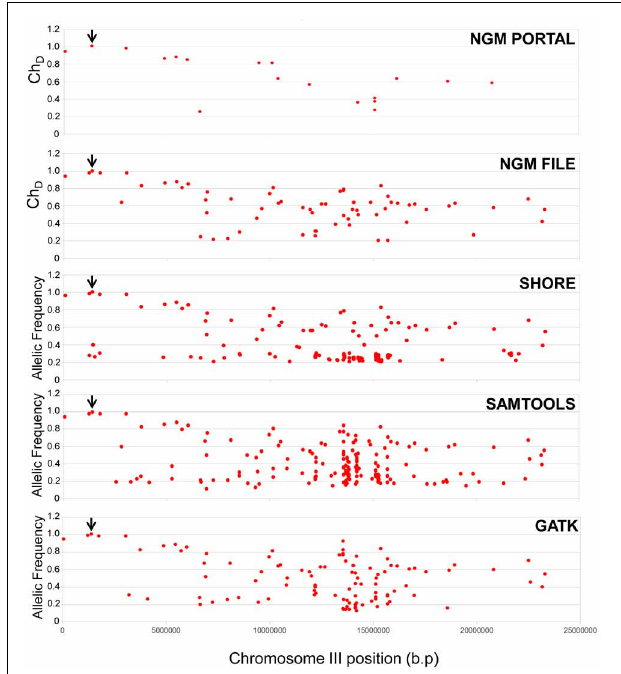
FIGURE 5 | Comparison of different SNP calling pipelines for causal mutant identification. Allelic frequencies (GATK/samtools/SHOREmap) or dischordant chastity (NGM) scores for all SNP resolved using mir159a parent and BCF 2 mutant whole genome sequence data. “NGM portal” refers to the web based output where the SNP parent filtered .emap file was interrogated, whereas “NGM file” refers to the analysis of the raw .emap files prior to loading into the web portal, where the mutant line has been filtered of the mir159a parent SNPs. The SNP representing the causal mutation in HASTY is indicated by the black